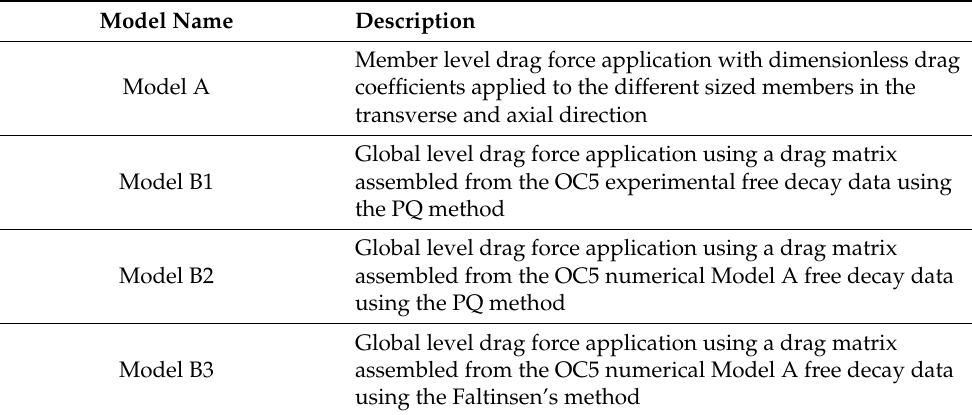
Table 4. Overview of the numerical models with different drag force